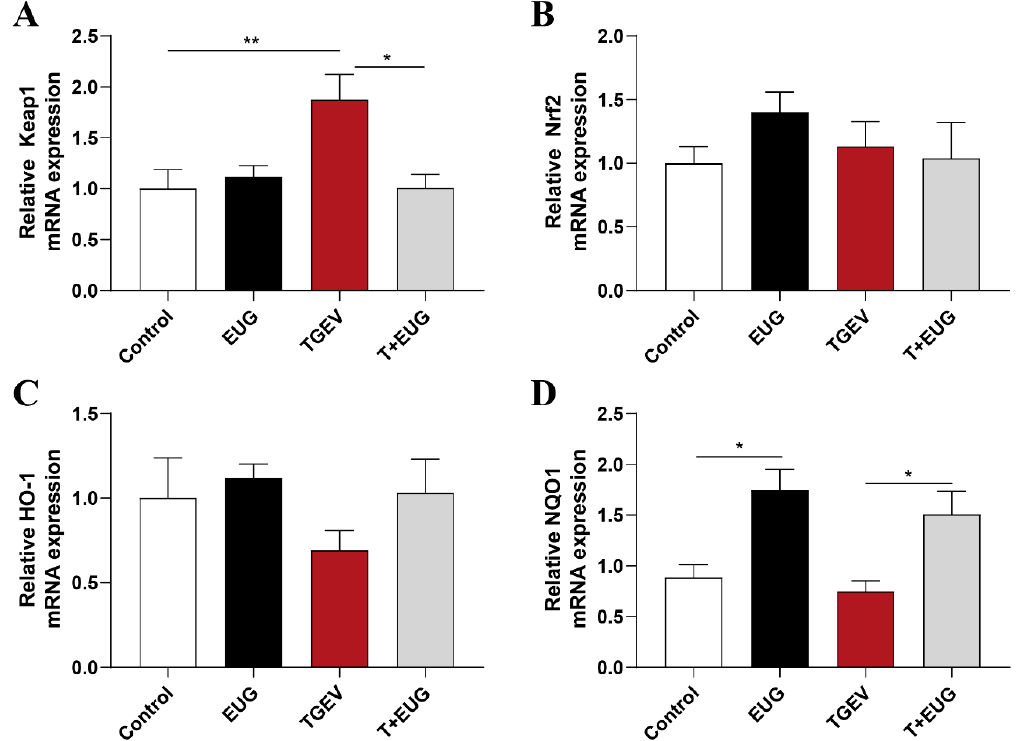
Figure 2. Effects of eugenol on jejunum antioxidation-related genes in TGEV-infected weaned pig- lets. ( A – D ) Relative mRNA expressions of Keap1, Nrf2, HO-1 and NQO1 in the jejunum mucosa ( n = 6–8). Data are expressed as the mean ± SEM. * p < 0.05, ** p < 0.01.